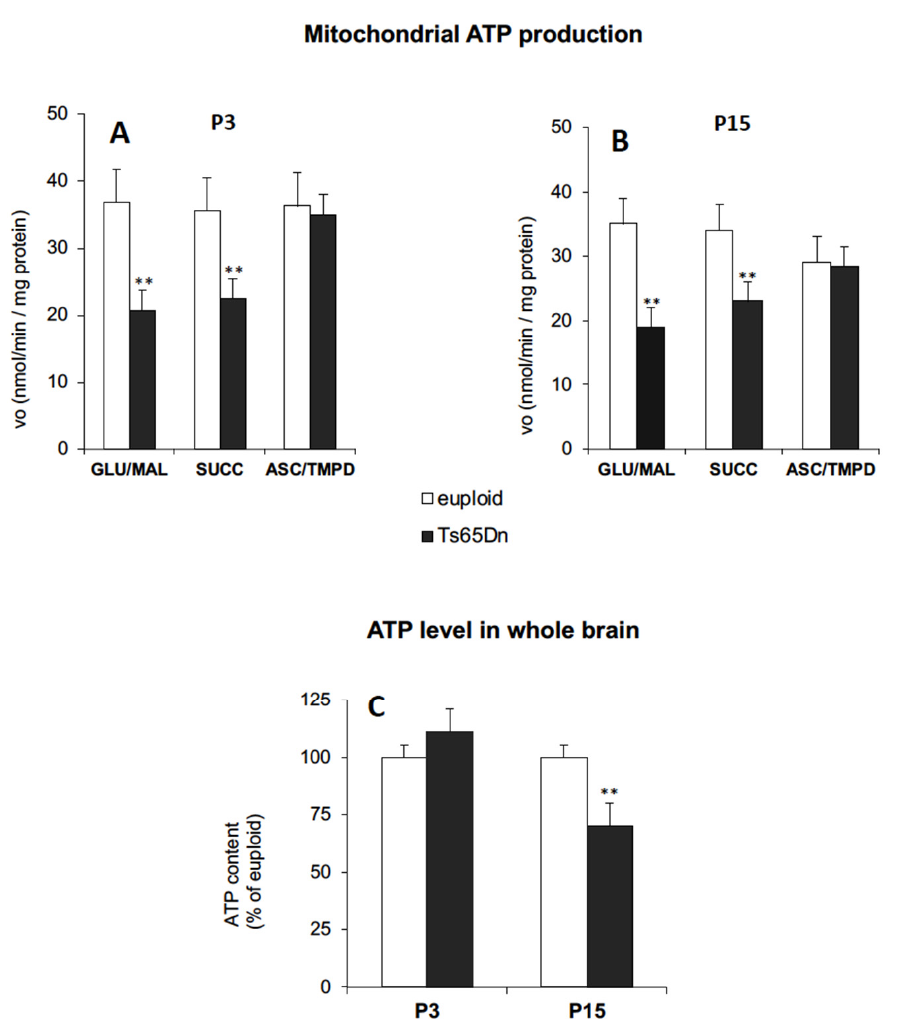
Figure 1. Aberrant mitochondrial bioenergetics in the Ts65Dn mouse brain. ( A , B ) The rate of mito- chondrial ATP production (vo) was measured in mitochondria isolated from the brain hemispheres of P3 ( A ) and P15 ( B ) Ts65Dn mice and euploid mice, in the presence of the respiratory substrates glutamate plus malate (GLU/MAL; 5 mM each), succinate (SUCC; 5 mM) or ascorbate plus TMPD (ASC/TMPD; 5 mM and 0.5 mM, respectively), and expressed as nmoles ATP produced/min/mg protein. ( C ) ATP levels were assayed spectrophotometrically in neutralized perchloric acid extracts of P3 and P15 cryopreserved brain hemispheres of Ts65Dn and euploid mice and are expressed as % of euploid controls. Data are the mean ± SD of two independent measurements ( n = 5 mice for each experimental group). Group differences were evaluated with Tukey’s test. ** p < 0.01: Ts65Dn vs. euploid